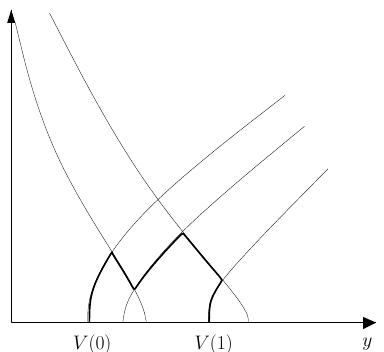
A weak solution on Ω following different energy